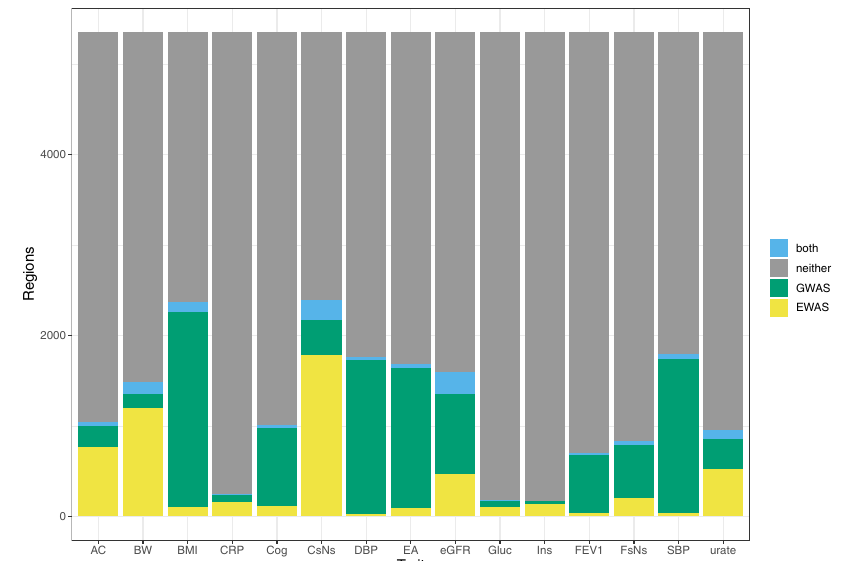
Fig. 2 | Overlapbetween genomicpositions identi fi edby corresponding GWAS and EWAS. The genome was divided into 500kb regions. Those where no probes on the HM450 array measured DNAm were excluded from the analysis. This left 5591 regions. Regions were counted as being identi fi ed by a GWAS if one or more SNPs in that region associated with the trait and as being identi fi ed by an EWAS if one or more CpGs in that region associated with the trait. Neither = no GWAS or EWAS sites identi fi ed in the region, GWAS = GWAS sites only were identi fi ed,